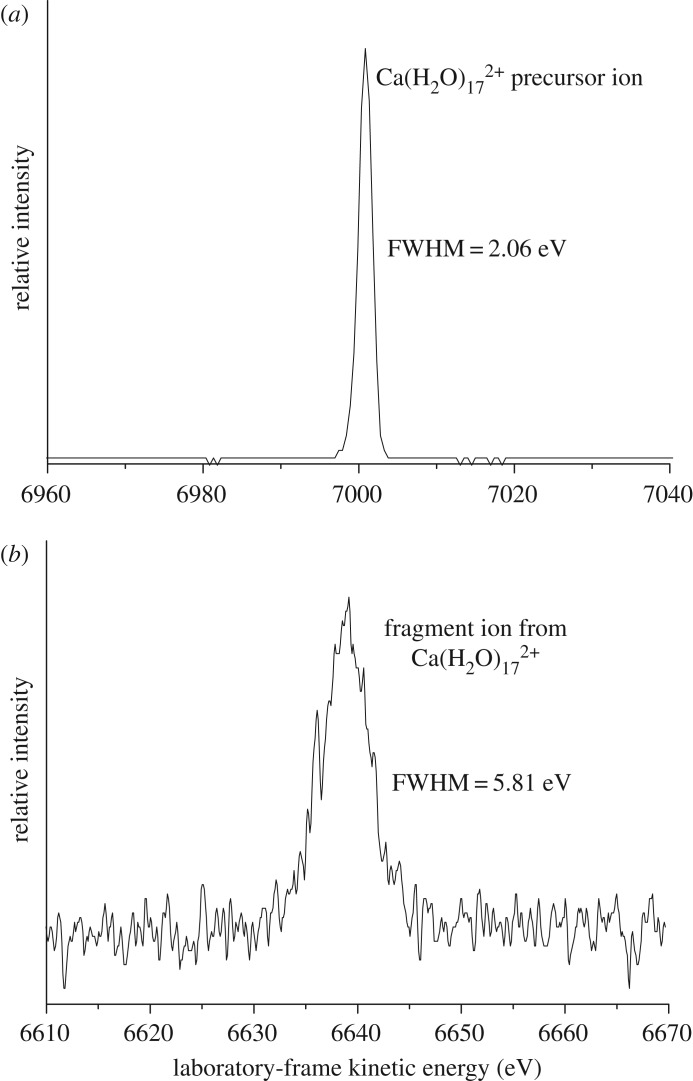
Examples of precursor (a) and fragment (b) peak profiles taken from the experimental results. The additional FWHM (full width half maximum) seen for the fragment ion is due the release of kinetic energy during the fragmentation process.